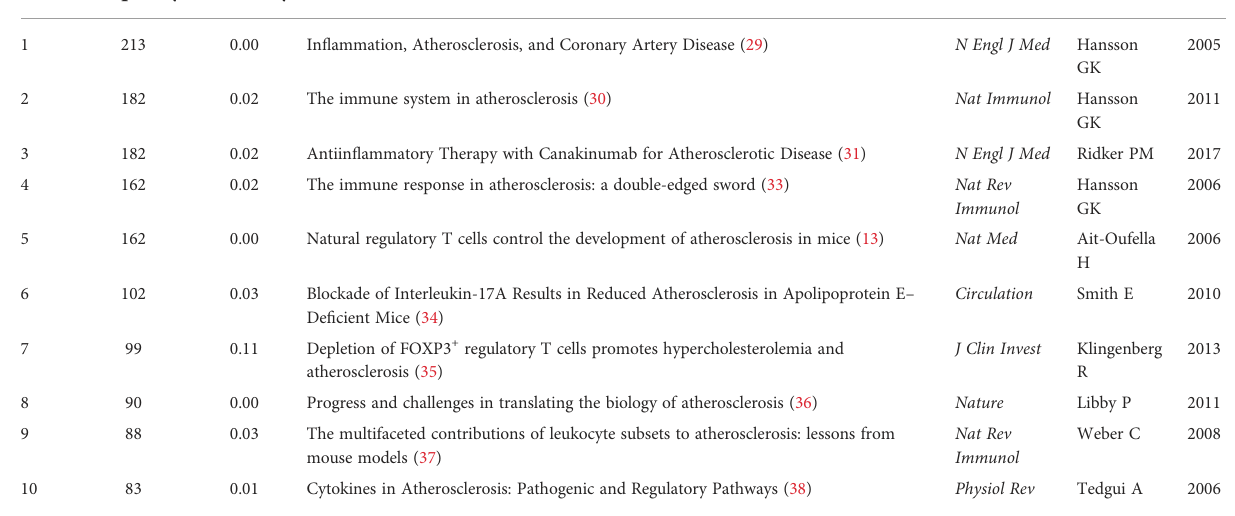
TABLE 7 Top 10 cited references of publications in T cell and AS. Rank Frequency